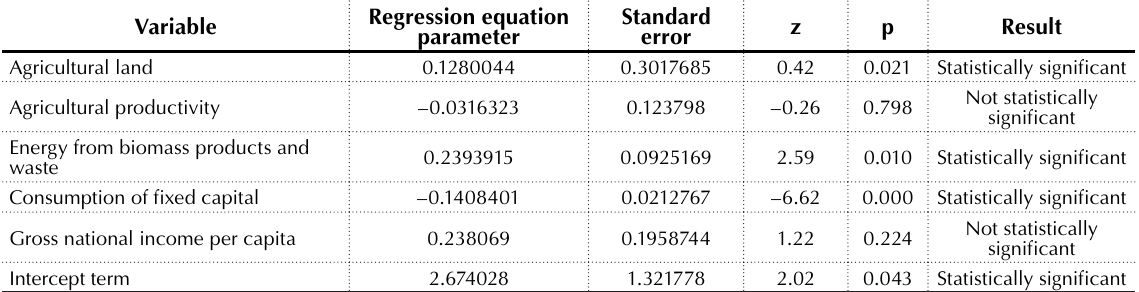
Table 7. Results of a random effects regression model based on variables after taking the logarithm